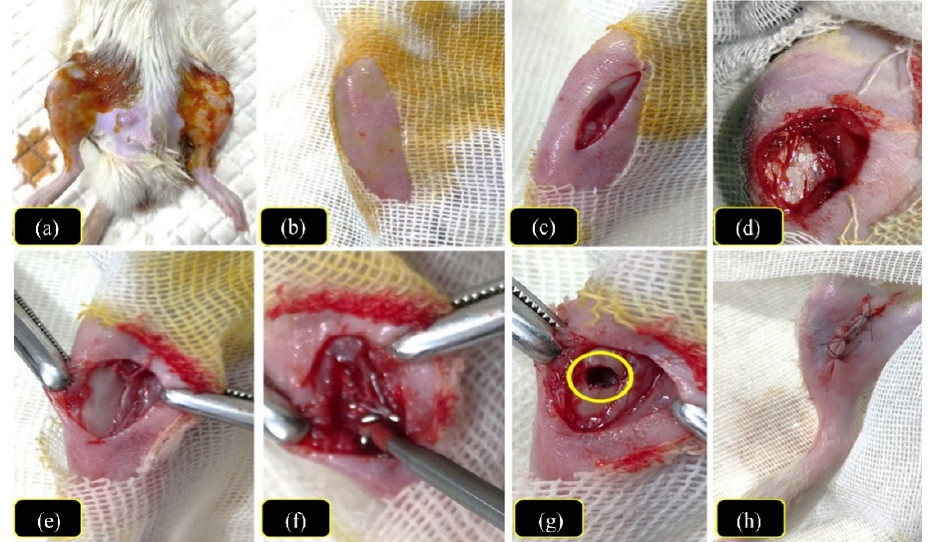
Figure 2. The photographs are showing the steps of the surgical procedures of the induced tibial bone defect; ( a ) the hind limbs were shaved and prepared aseptically, ( b ) the exposed tibial region, ( c ) the skin incision made at the flat part of the tibial shaft, ( d ) cutting the subcutaneous tissues to expose the tibial bone, ( e ) the exposing of the tibial bone, ( f ) induction of a uni-cortical bone defect (1 mm in diameter) using an electric microdrill, ( g ) the defect hole “yellow circle,” and ( h ) closure of the dissected wound and subcutaneous tissues using Vicryl sutures.